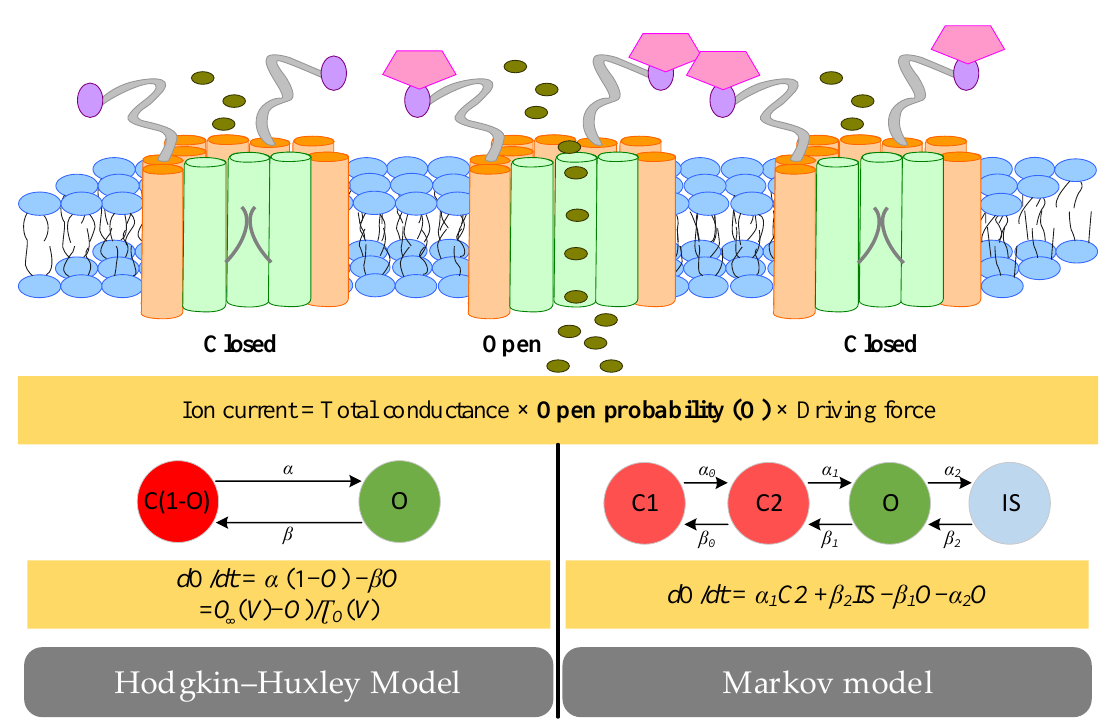
Figure 6. Hodgkin-Huxley-type and Markov-type models of ion channels. Ion currents through specific types of ion channels are determined by a fixed total conductance, the open probability (O) and the driving force. The open probability (O) can be represented as Hodgkin-Huxley functions with a single state variable, or Markov models with a number of states.